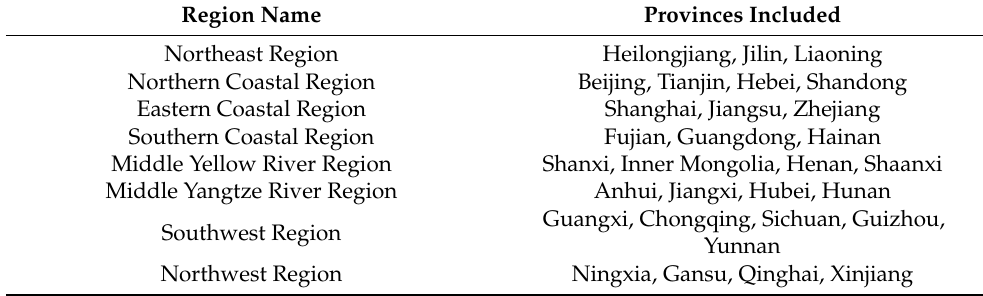
Table 4. Division of eight economic regions. Region Name Provinces Included Northeast